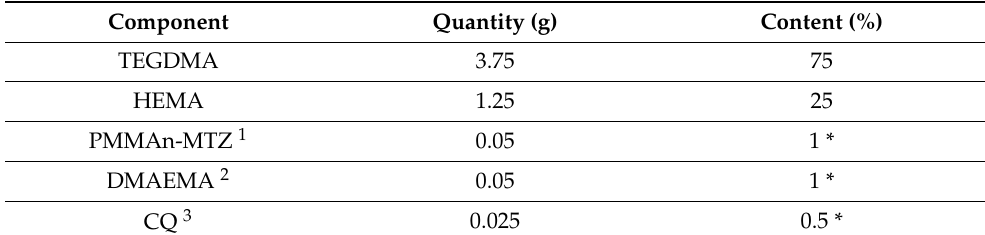
Table 2. Composition and percentage content of the experimental